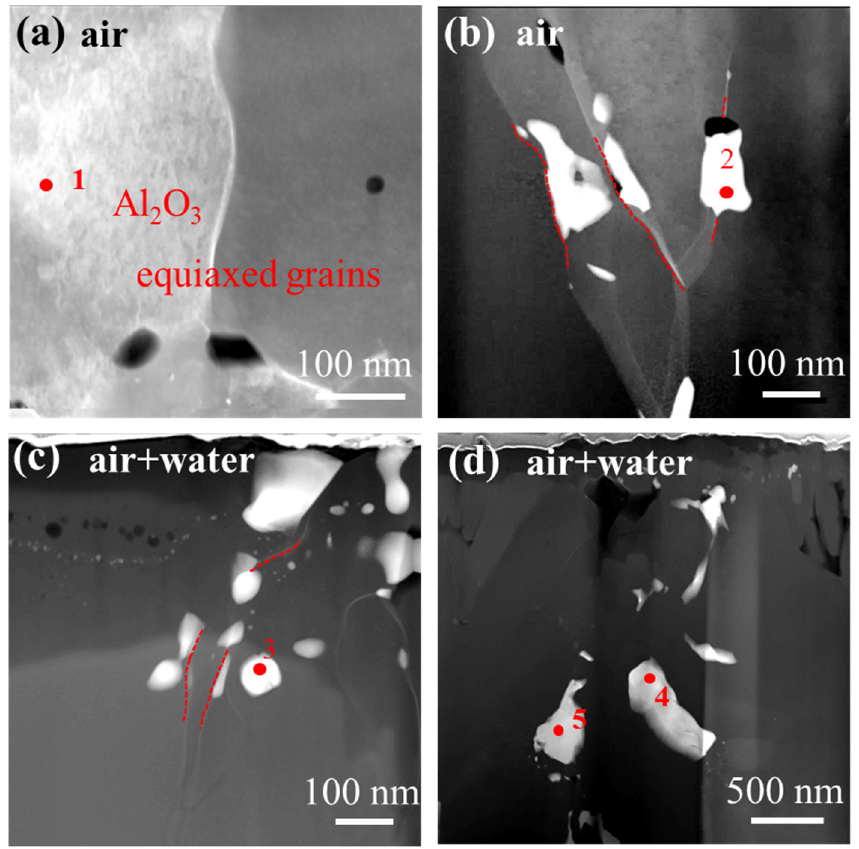
Figure 8. STEM microstructure of the NiCrAlYHf alloy (cut by FIB) after 100 h at 1100 °C: in air ( a , b ) and air-water vapor ( c , d ). and air-water vapor ( c , d